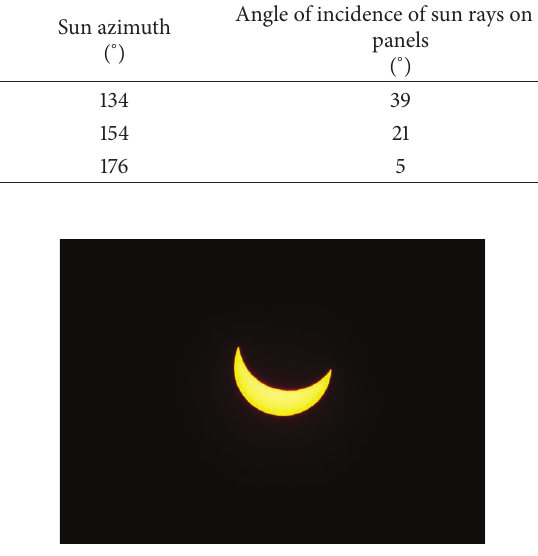
Figure 2: Sun in the maximum phase of the eclipse visible from our university campus in